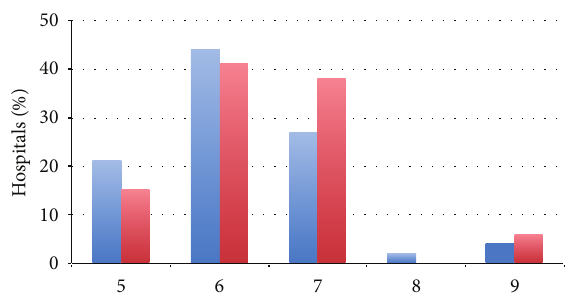
Figure 1: Minimum Bishop score after cervical ripening required for induction of labor by amniotomy and oxytocin augmentation in women without and with a prior cesarean delivery in The Netherlands in 2010. Missing value: 𝑛 = 1